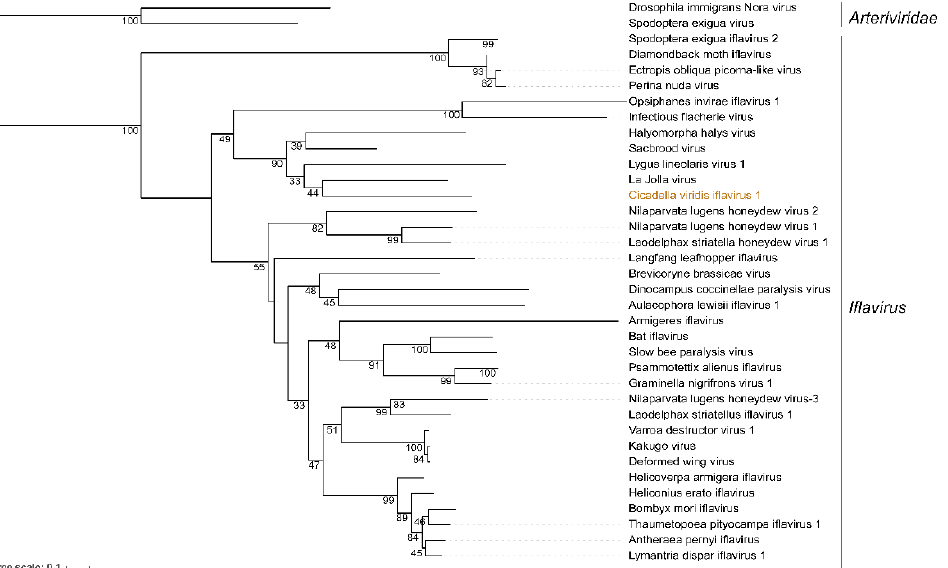
Figure 2. Phylogenetic analysis of Cicadella viridis iflavirus 1 (CvIfV1) with other iflaviruses. Maximum likelihood phylogenetic tree based on the RNA-dependent RNA polymerase domain was constructed with a bootstrap of 1000. Scale bars represent percent divergence. Drosophila immigrans Nora virus and Spodoptera exigua virus are used as an outgroup.